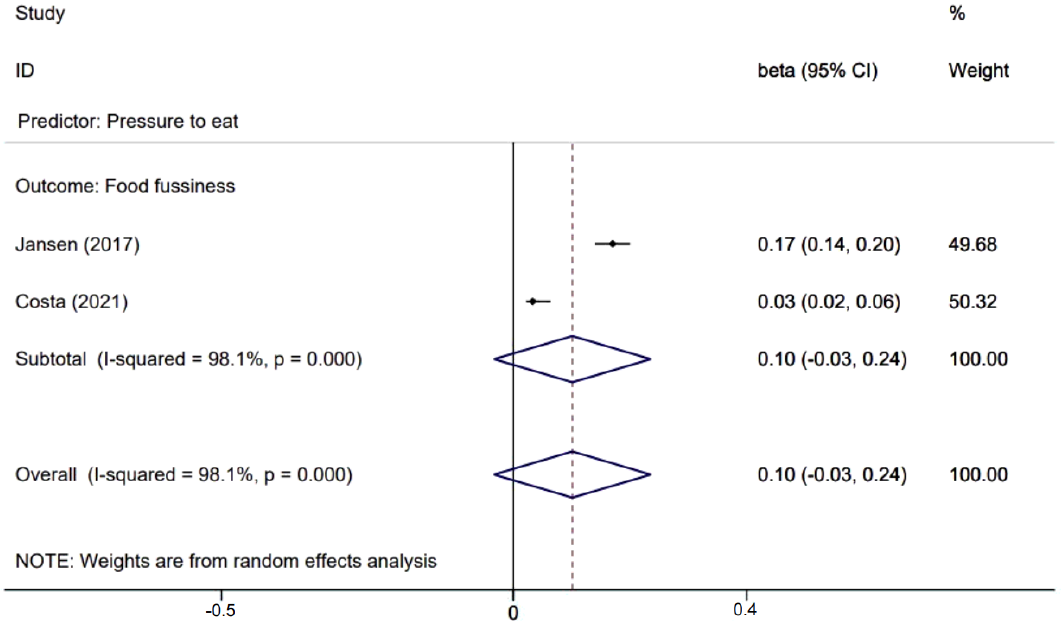
Figure 3. Effects of parental pressure to eat on child eating behaviors.